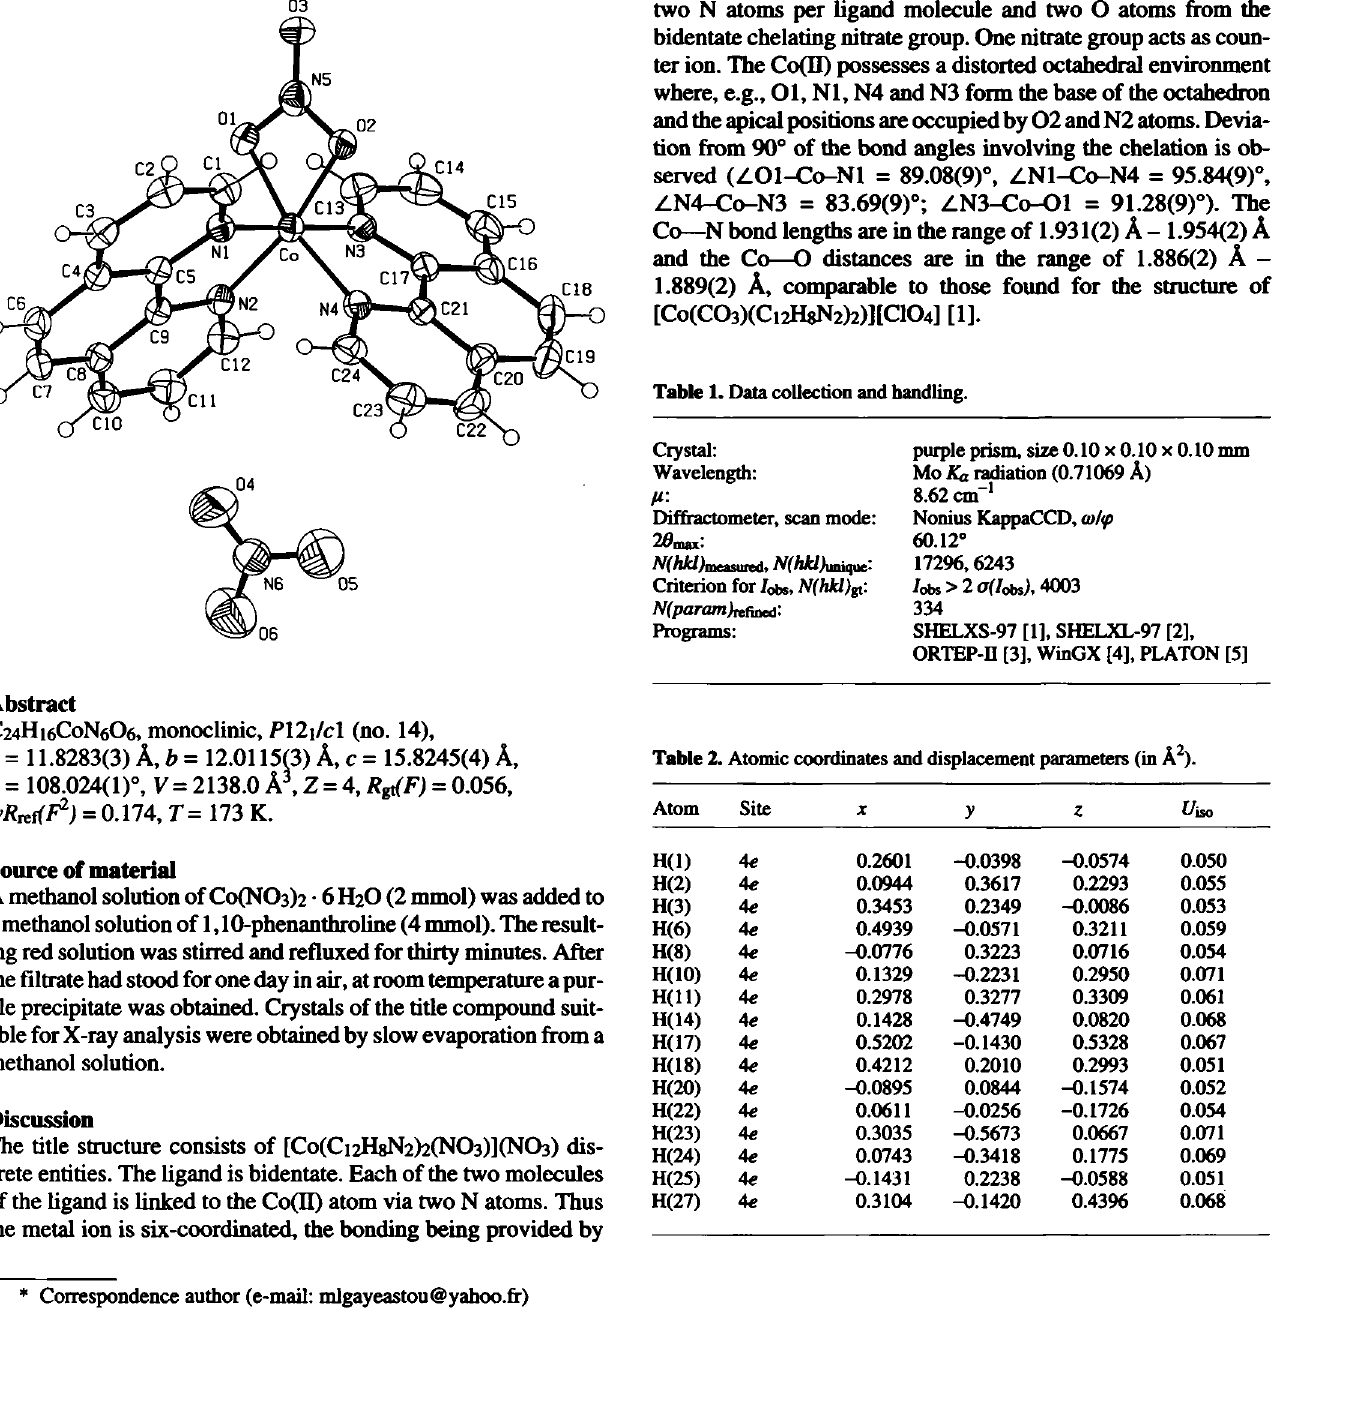
Table 1. Data collection and handling.